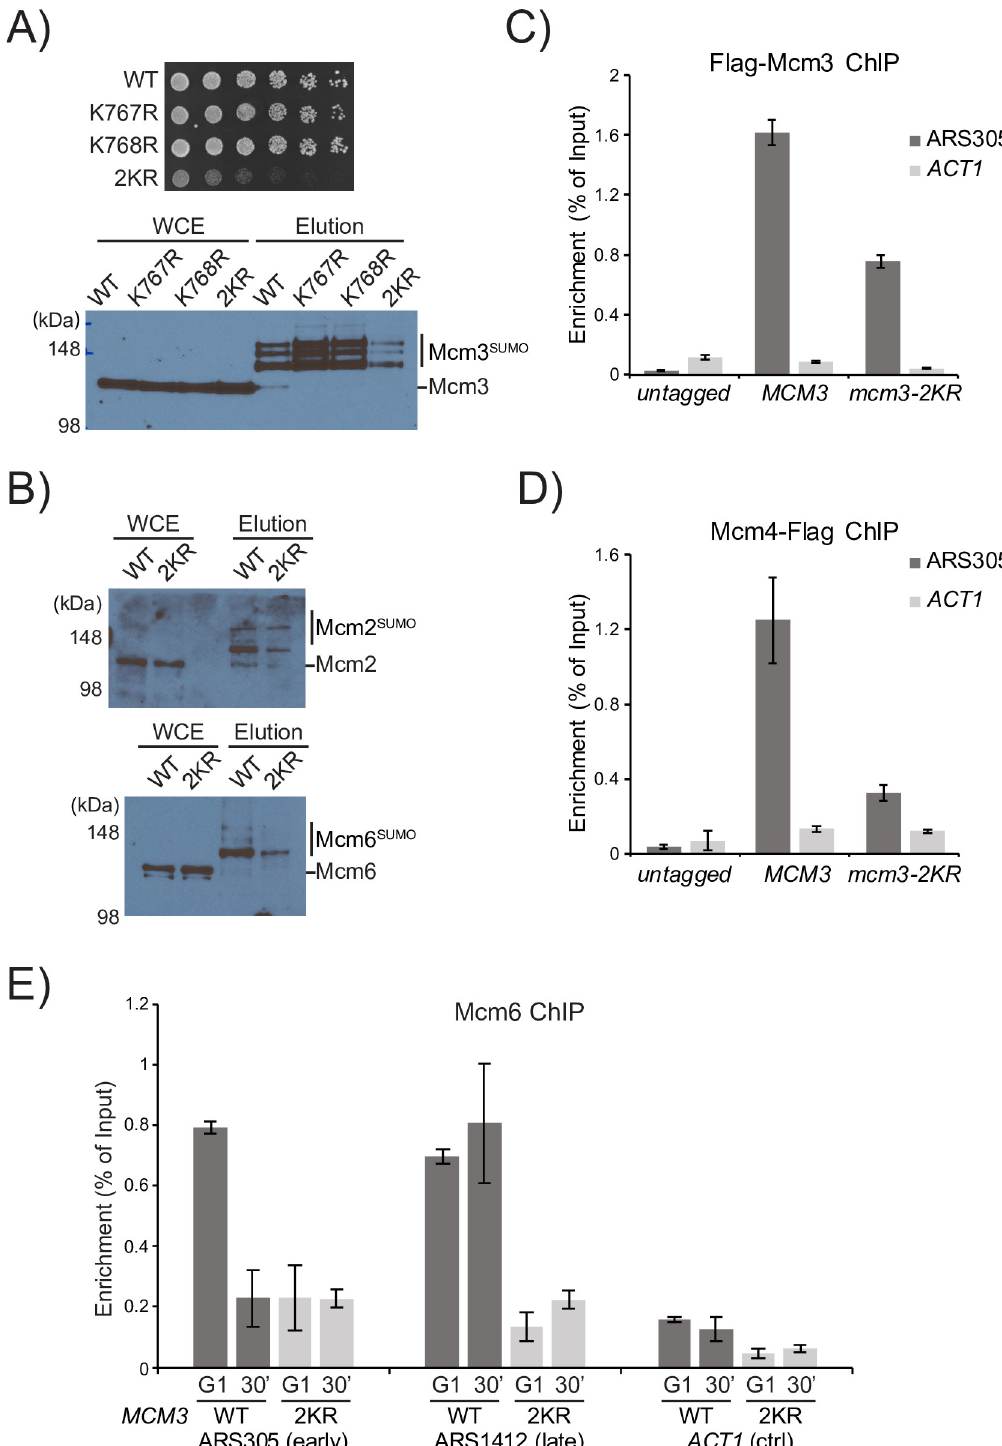
Fig 3. mcm3-2KR reduces MCM sumoylation and impairs its loading at both early and late origins. (A) The mcm3-2KR (K767R and K768R) mutant grows poorly and has a significantly reduced overall sumoylation, while K767R or K768R has little effect on cell growth or bulk Mcm3 sumoylation. These mcm3 mutants were integrated at the chromosomal locus. (B) mcm3- 2KR reduces sumoylated Mcm2 and Mcm6 in alpha-factor arrested G1 cells, showing that mcm3-2KR indirectly reduces sumoylation of the other MCM subunits. (C-D) ChIP-qPCR of Flag-Mcm3 and Mcm4-Flag in mcm3-2KR cells revealed